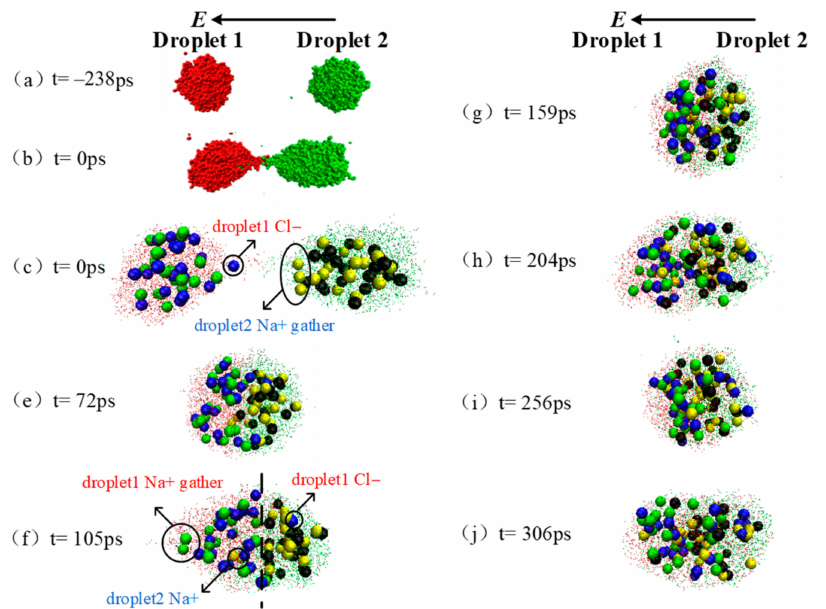
Figure 6. Schematic of droplet coalescence and deformation after contacting at AC electric field ( f = 10.0 GHz, E = 0.77